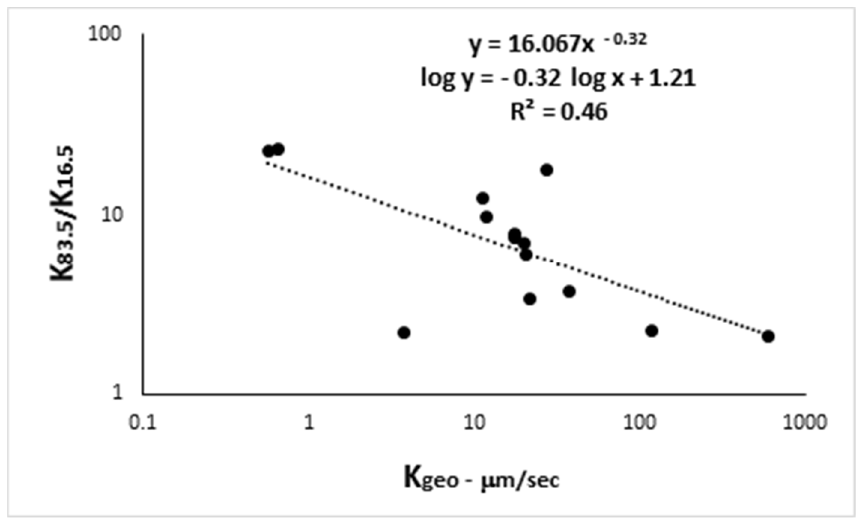
Figure 5. Inverse relationship between the geometric mean K geo of K sat and the dispersion parameter K 83.5 / K 16.5 . Table 6. Fraction of measured K sat values in expected classes, and in one or two classes higher or lower than the ex- pected class. Higher K sat by Lower K sat by One Category Two Categories One Category Two Categories